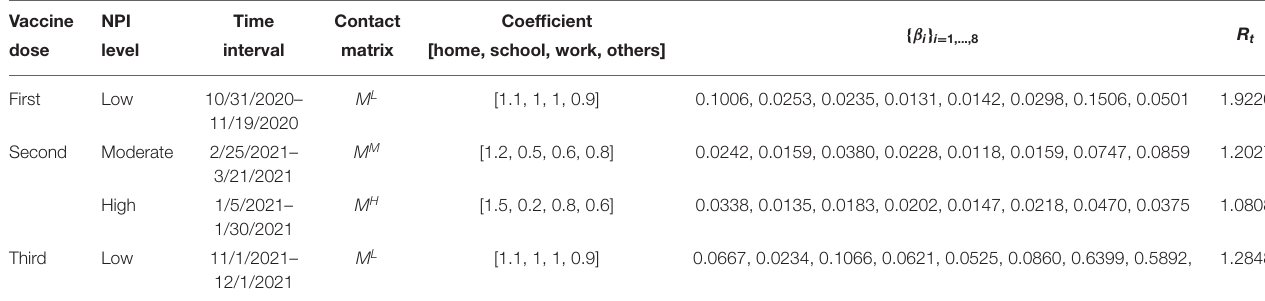
TABLE 2 | Age-specific transmission probability is estimated under different time periods for corresponding NPI levels. Vaccine NPI Time Contact Coefficient